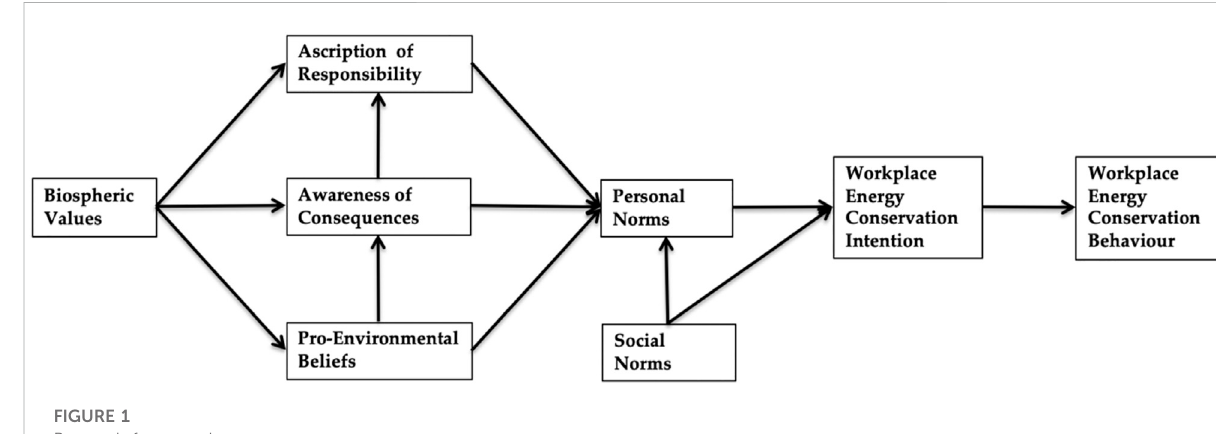
FIGURE 1 Research